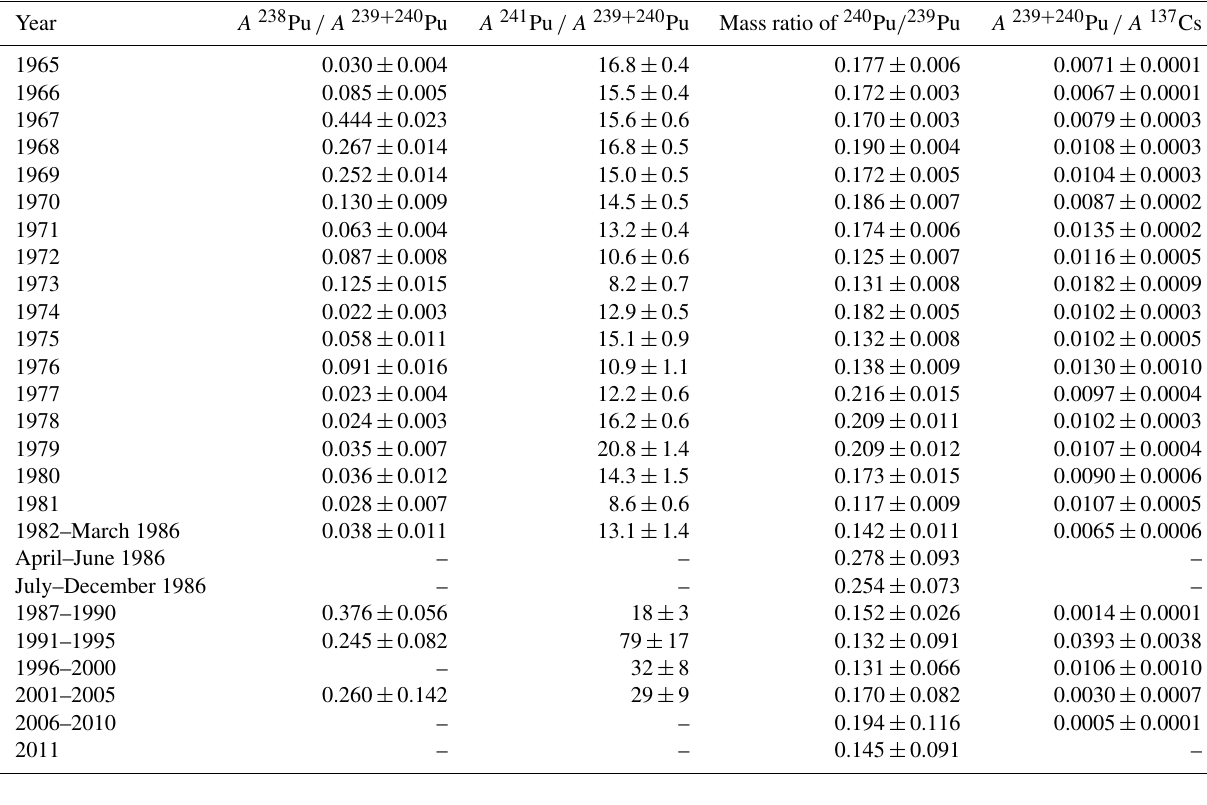
Table 2. The activity ratios of 238 Pu / 239 + 240 Pu, 241 Pu / 239 + 240 Pu and 239 + 240 Pu / 137 Cs and the mass ratio of 240 Pu / 239 Pu in the air filters collected in Rovaniemi. The uncertainty is 1 σ error for the activity ratios and 2 σ error for the mass ratio. The symbol “–” means that one or both isotopes had a concentration below the detection limit.